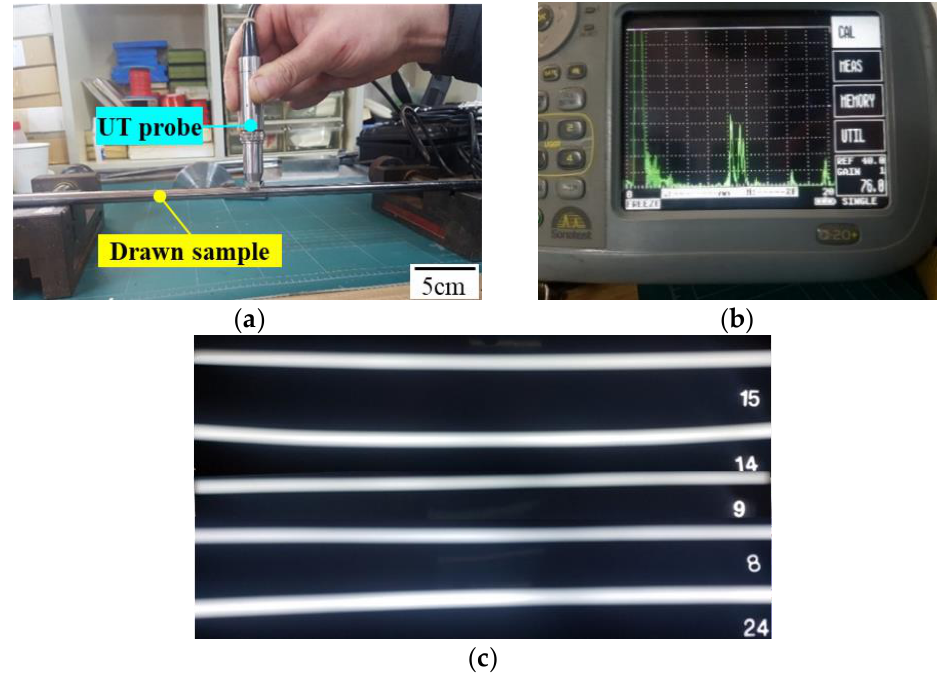
Figure 4. ( a ) Non-destructive inspection being conducted on the drawn specimen, ( b ) ultrasonic testing (UT) monitor, and ( c ) drawn specimens inspected by radiographic testing (RT).